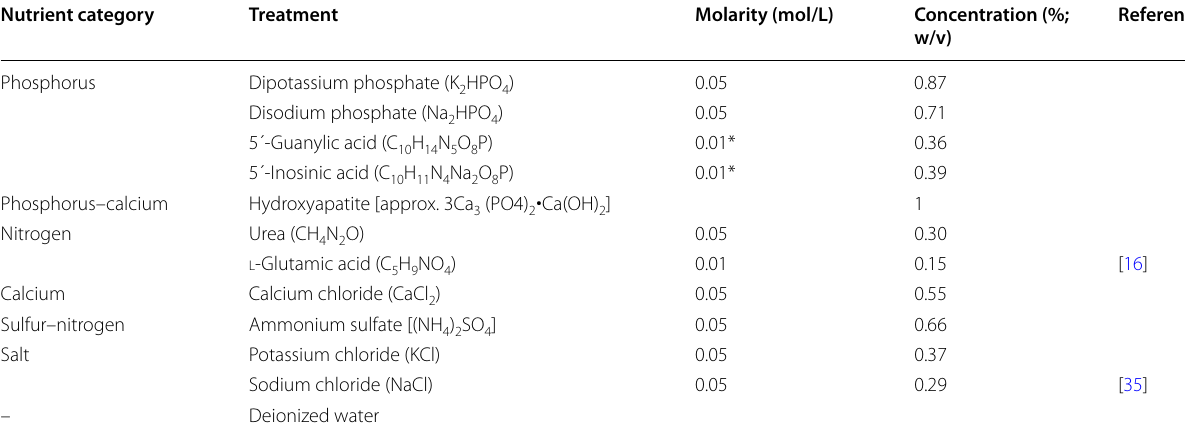
Table 1 Nutrition concentration used in this study